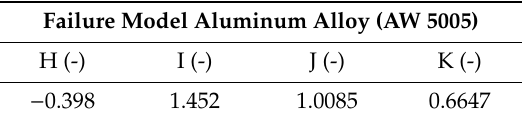
Table 5. Parameters for failure models [21].